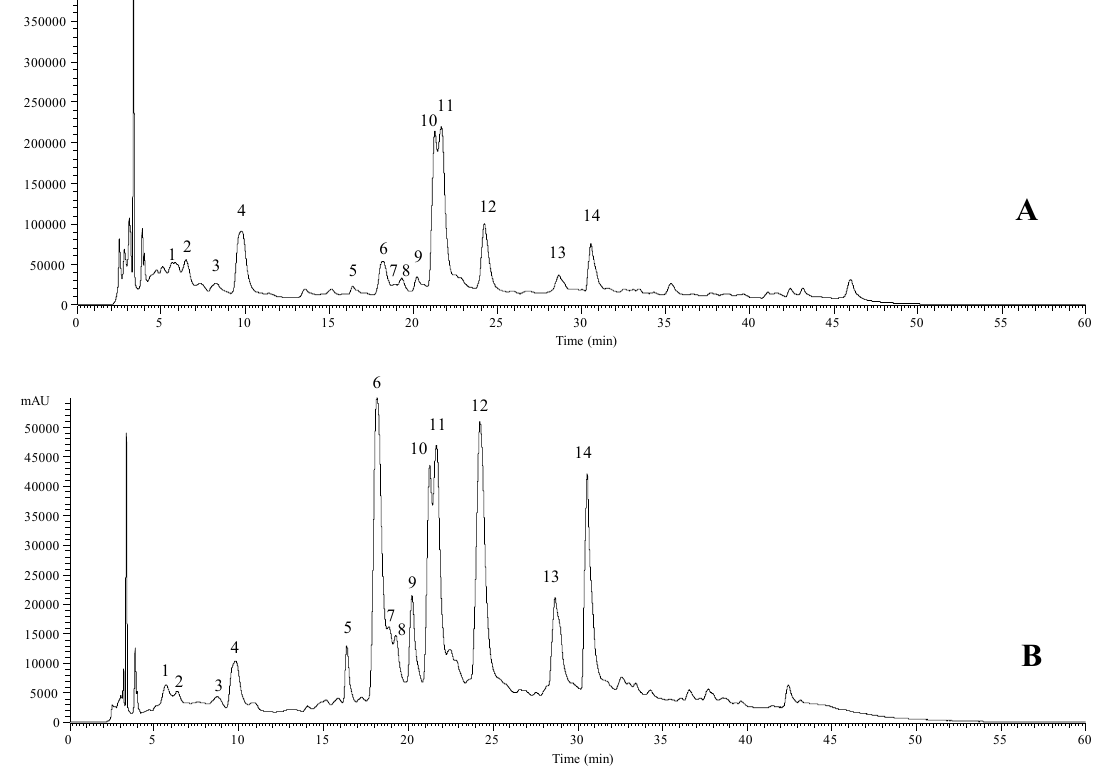
Figure 1. Phenolic profile of R. officinalis flowers recorded at 280 nm ( A ) and 370 nm ( B ) . Numbers 1 to 14 refer to peaks from Table 1.